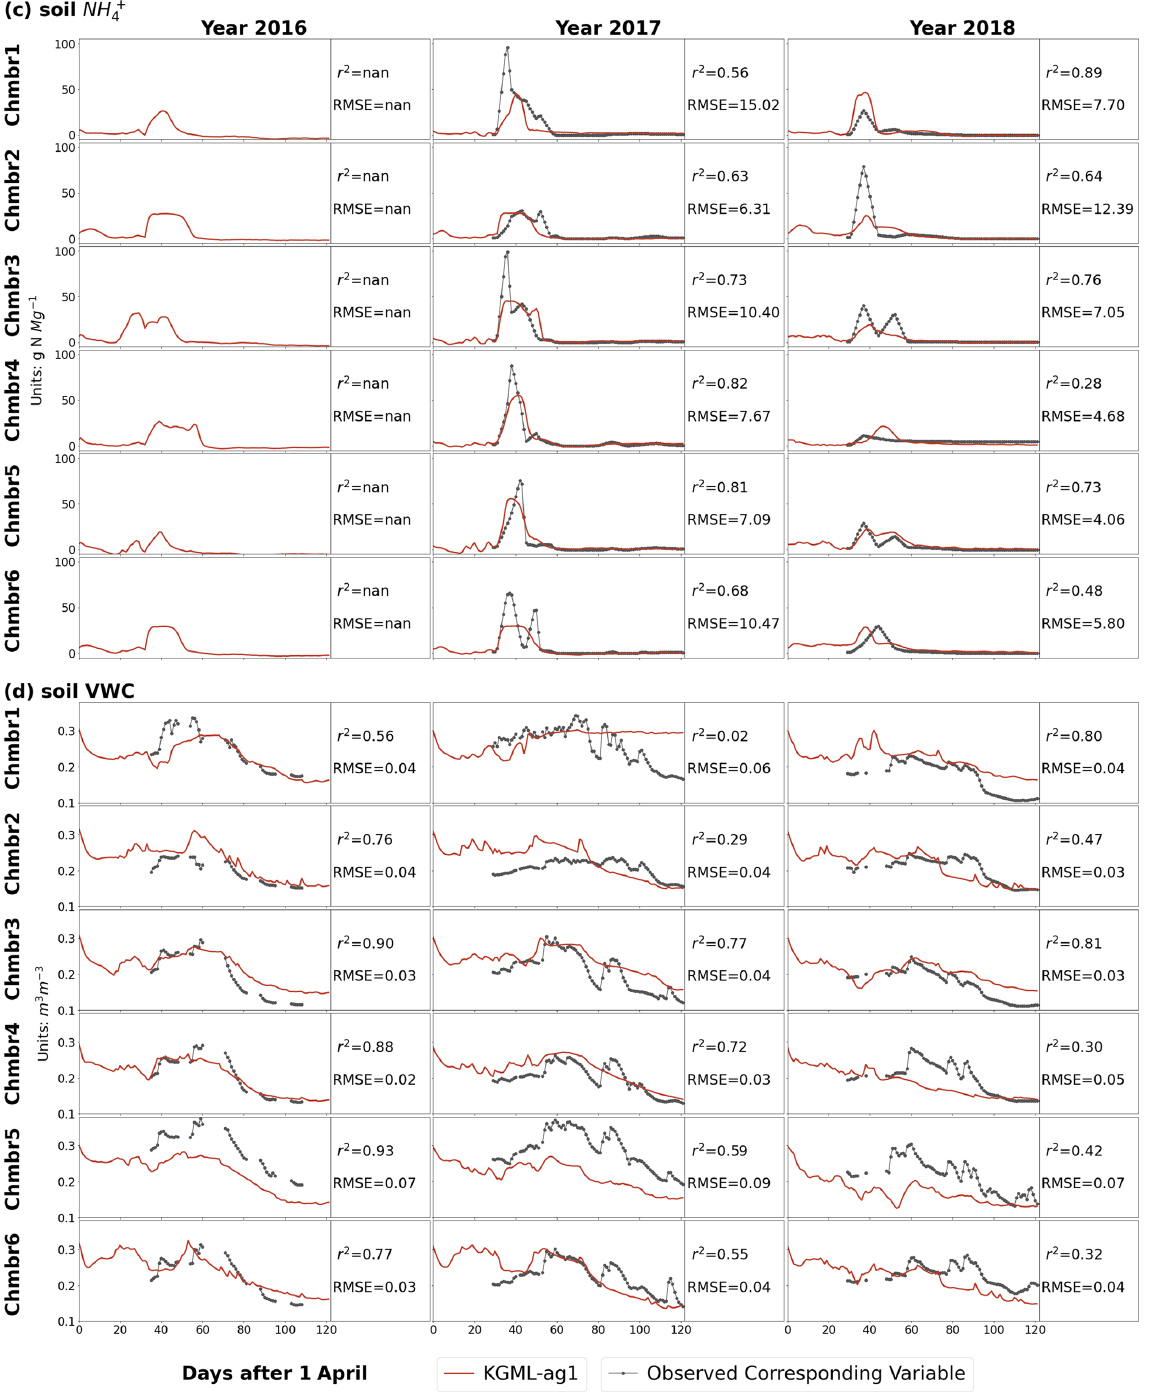
Figure 3. Leave-one-out cross validation of time series of IMVs predicted by KGML-ag1 model (red line). Observations are shown as black line-dots. Validation results for each chamber were based on out-of-sample predictions by models trained by other five chambers. Chmb is the abbreviation for chamber. r 2 and RMSE are calculated and present in each year and chamber. The CO 2 flux (a) and soil NO 3 − concentration (b) units are gCm − 2 d − 1 and gNMg − 1 , respectively. The soil NH 4 + concentration (c) and soil VWC (d) units are gNMg − 1 and m 3 m − 3 ,